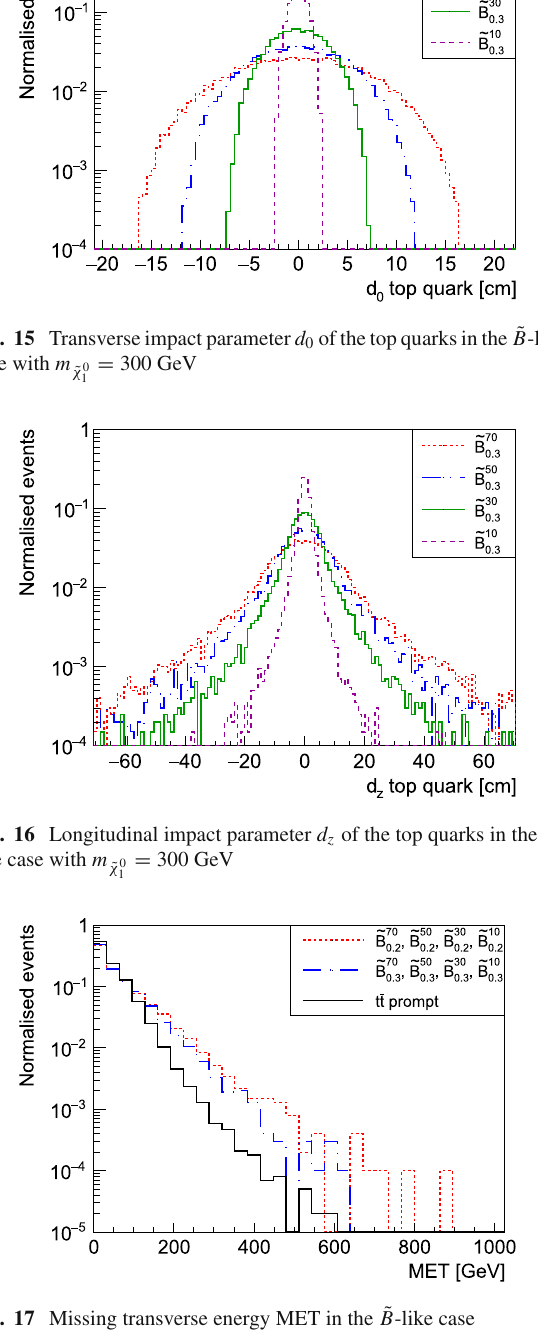
Fig. 17 Missing transverse energy MET in the ˜ B -like case final state) but is explained by the selection cut of 30 GeV on the jet transverse momentum.